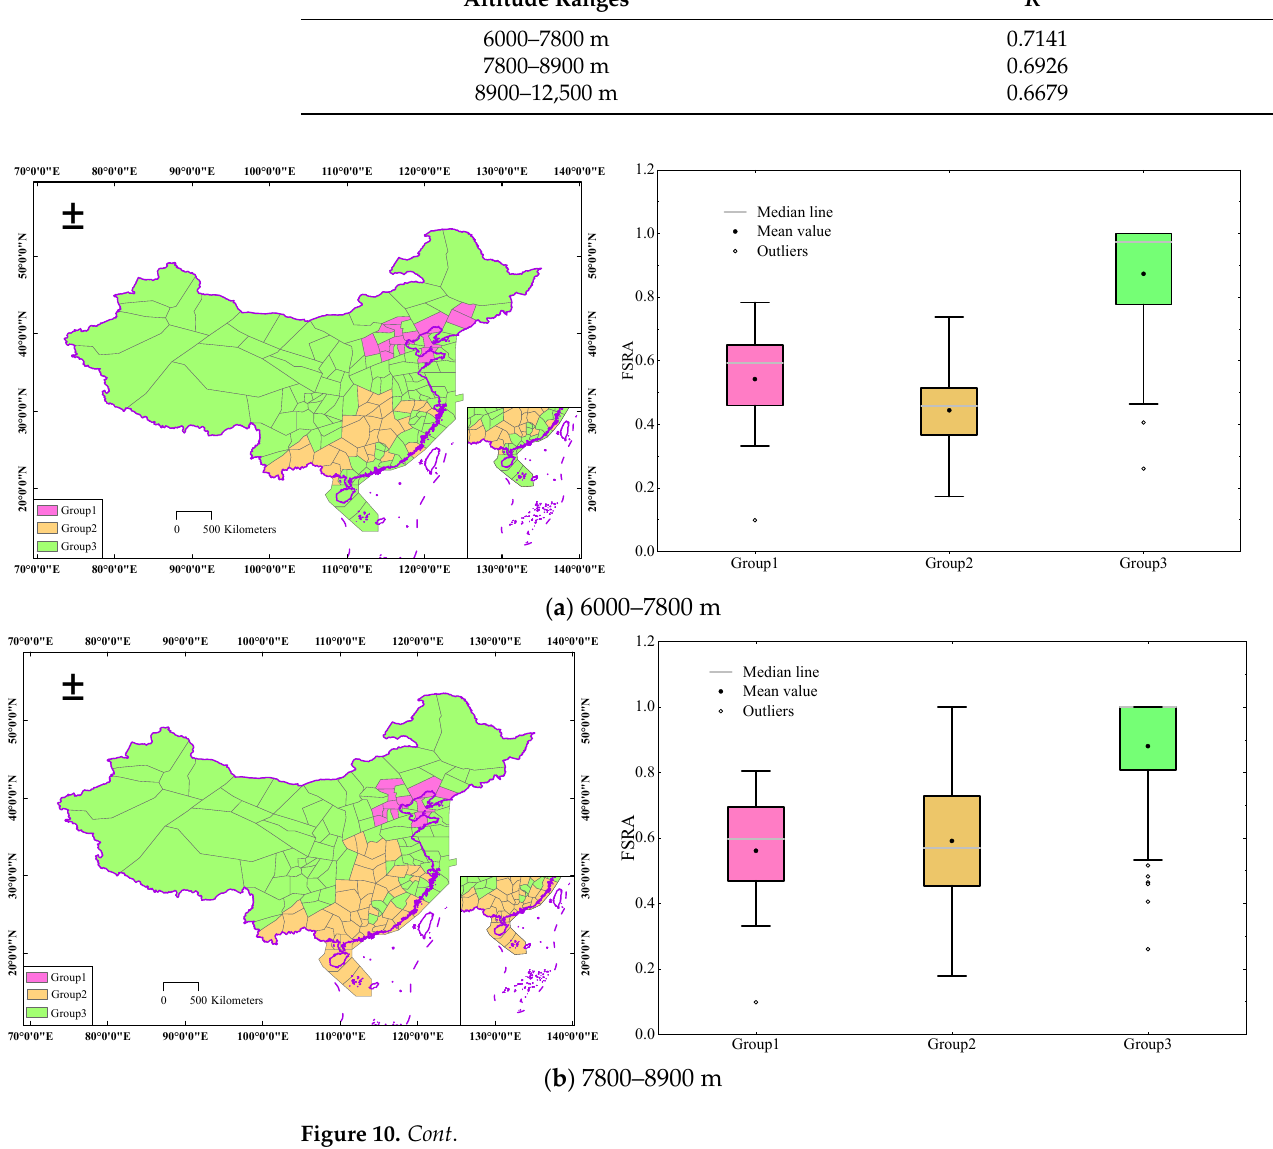
Table 6. Grouping analysis results of FSRA in Chinese airspace. Altitude Ranges